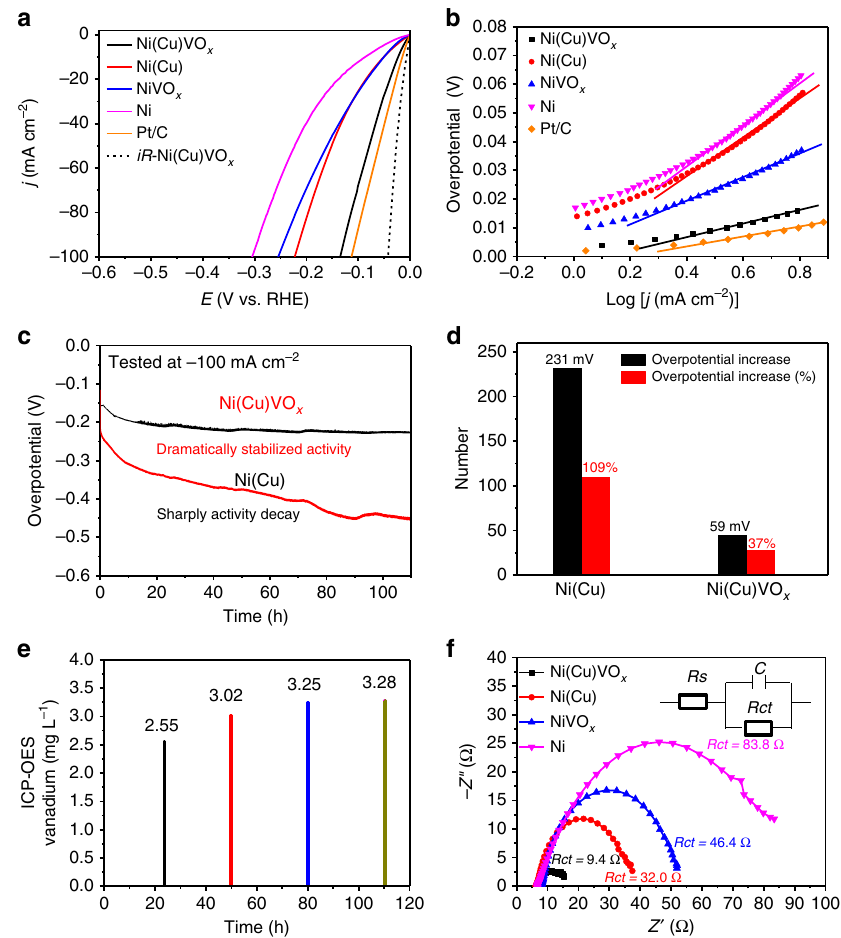
Fig. 2 Electrochemical characterization of the Ni(Cu)VOx electrode. a LSV curves and b Tafel plots for Ni(Cu)VOx and control samples without iR compensation. The black dotted curve is the HER activity on Ni(Cu)VOx electrode with iR correction. c Chronopotentiometric curve of Ni(Cu)VOx in comparison with Ni(Cu). d Catalytic activity comparison after long-term stability. e ICP-OES analysis of vanadium in 1.0 M KOH solution during the 110 h HER measurement. f EIS spectra of the prepared electrodes. All the electrochemical results were carried out in 1.0 M